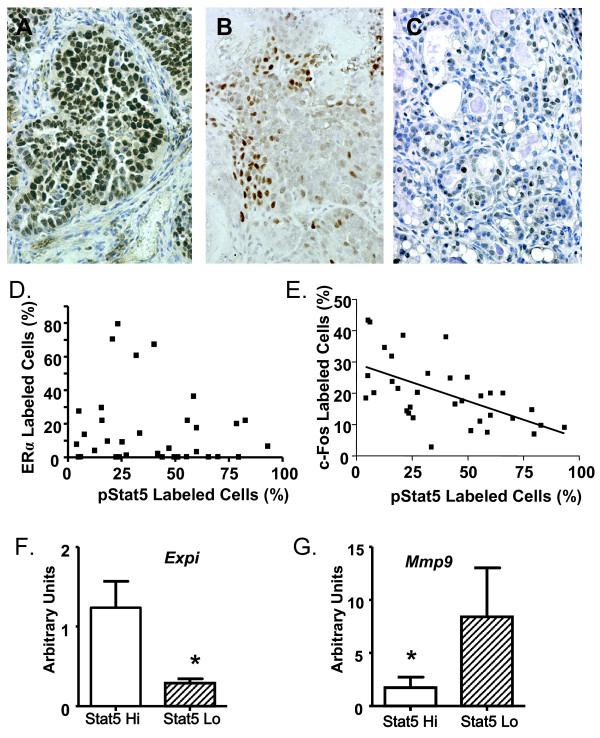
PRL-induced carcinomas demonstrate an inverse relationship between nuclear phosphorylated Stat 5 (pStat 5) and AP-1 proteins. (a) Nuclear pStat 5 staining in a glandular adenocarcinoma. (b) c-Fos expression in a glandular adenocarcinoma. (c) c-Jun staining in a glandular adenocarcinoma. (d) The proportion of tumor cells that express ERα and nuclear pStat5 is not correlated. (e) Carcinomas exhibit a significantly negative correlation between the proportion of cells that contain nuclear pStat 5 and c-Fos (P < 0.0001, R = -0.63). ERα, pStat 5, c-Fos and c-Jun expression were evaluated and quantitated as described in Materials and Methods. Each box represents a single carcinoma that arose in a different NRL-PRL nonparous female. Correlations were determined using Spearman's non-parametric test. (f)Expi mRNA is significantly increased in the adenocarcinomas expressing highest pStat5, compared to the lowest 5 (mean ± s.e.m., N = 5; *, P = 0.003). (g)Mmp9 mRNA is significantly decreased in the adenocarcinomas expressing highest pStat5, compared to the lowest 5 (mean ± s.e.m., N = 5; *, P = 0.03). (f, g) Transcript levels were measured using qRT-PCR as described in Materials and Methods. Original magnification: a, b, c, 400x.